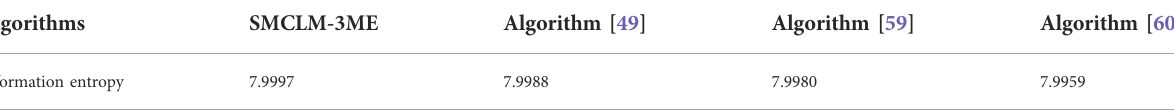
TABLE 3 Information entropy